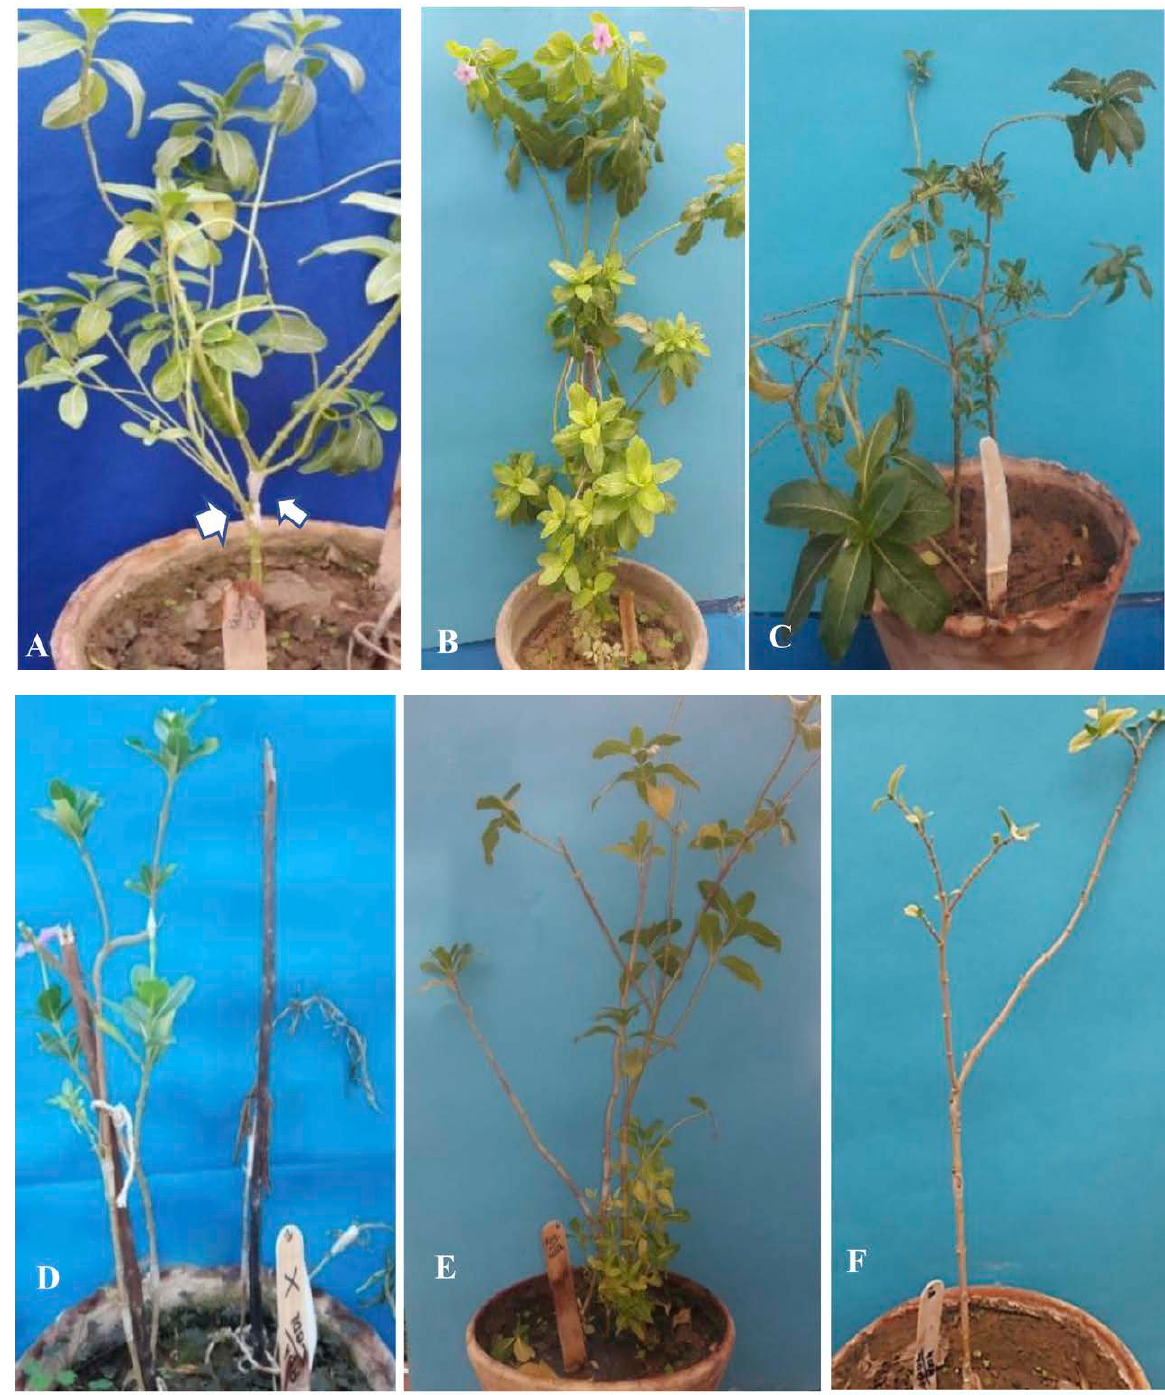
Figure 2. Disease symptoms in periwinkle plants doubly grafted with lime witches’ broom phytoplasma (LWBP) and another phytoplasma strain. (A) mild yellowing in a periwinkle plant grafted with LWBP and alfalfa witches’ broom phytoplasma (AWBP). (B) mild yellowing and shortened internodes with normal flowers in a periwinkle plant grafted with LWBP and sesame phyllody phytoplasma (SPhP). (C) mild yellowing, internode shortening, little leaf, and rosetting, in a periwinkle plant grafted with LWBP and tomato witches’ broom phy- toplasma (TWBP). (D) wilting, rosetting. (E) mild yellowing, shortened internodes, little leaf, crown proliferation. (F) severe symptoms of little leaf, yellowing and leaf drop in periwinkle plants grafted with LWBP and rapeseed phyllody phytoplasma (RPhP). In (A), right and left arrows indicate, respectively, scions from LWBP and